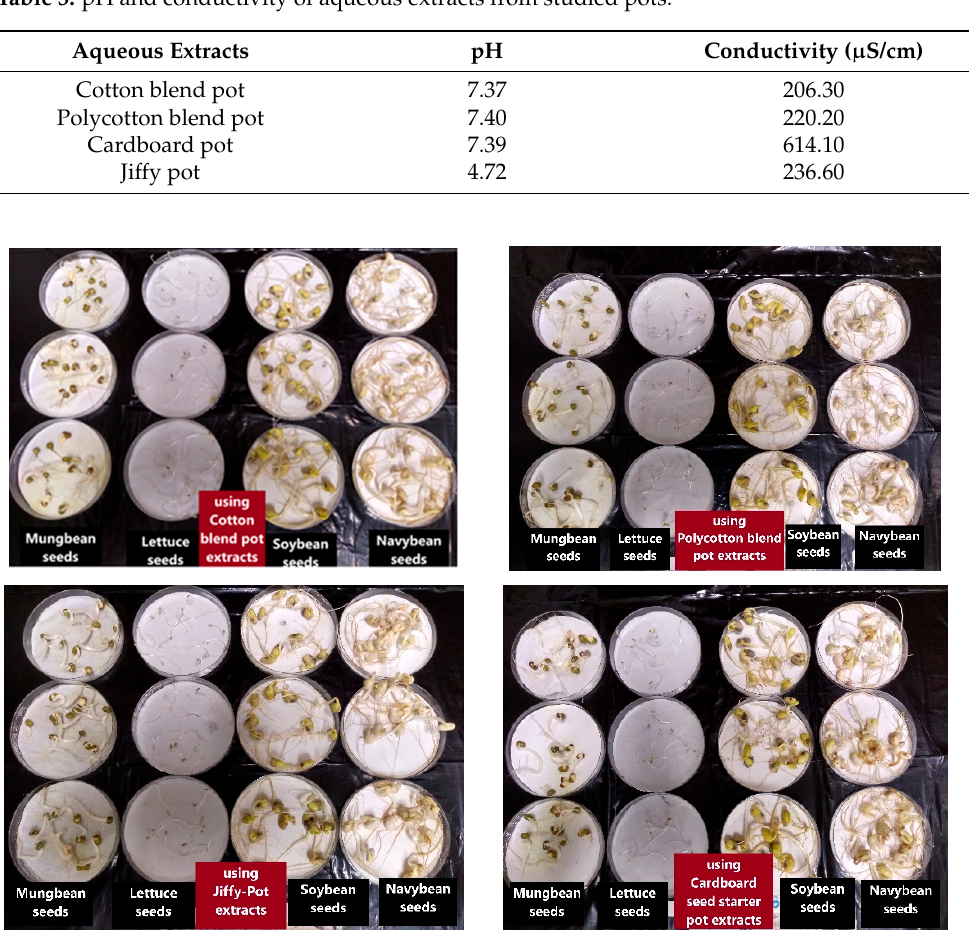
Figure 17. Germination tests of four seeds using cotton blend pot aqueous